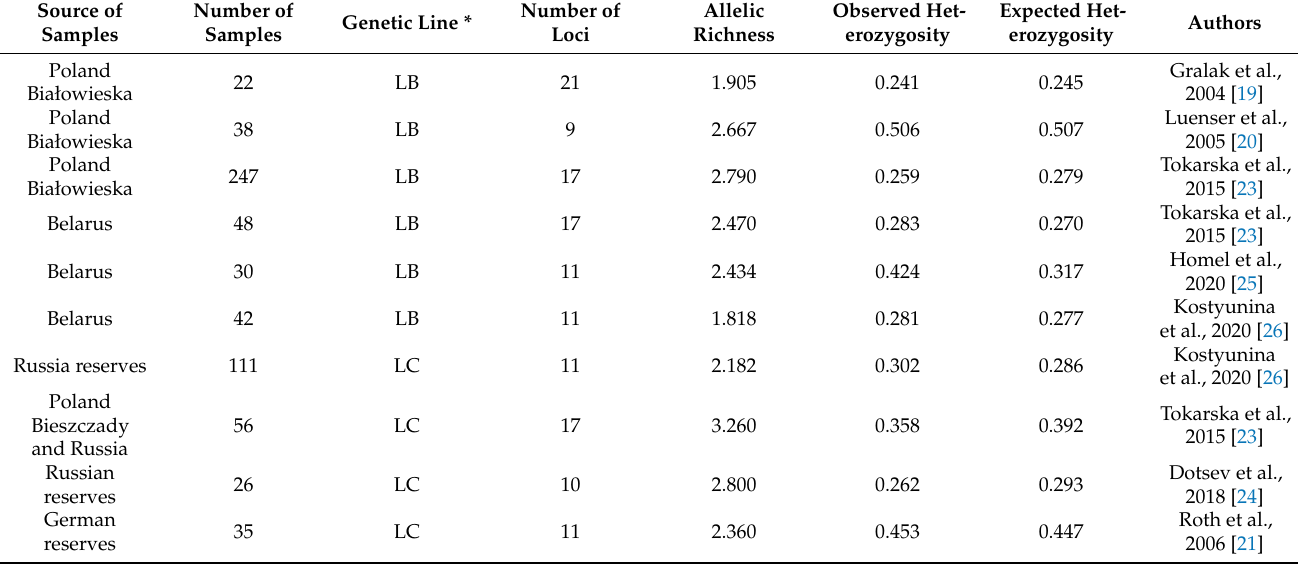
Table 1. Results of microsatellite locus diversity in wisent Bison bonasus obtained by other authors. Source of